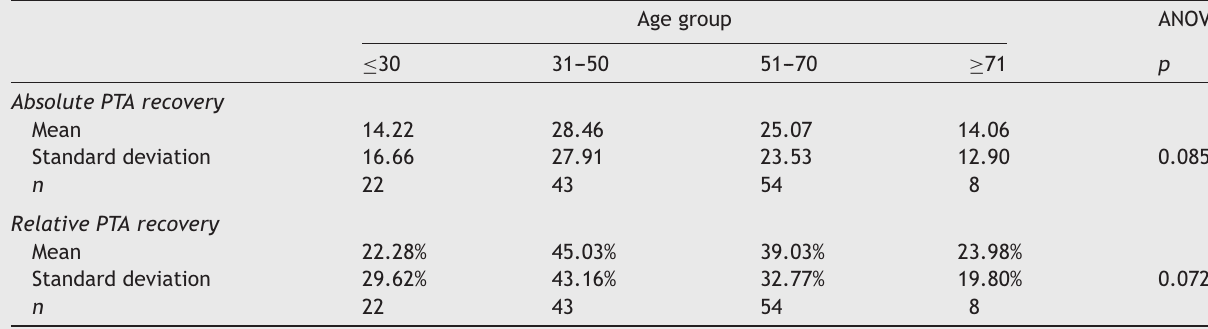
Table 1 ANOVA tests among age groups for recovery